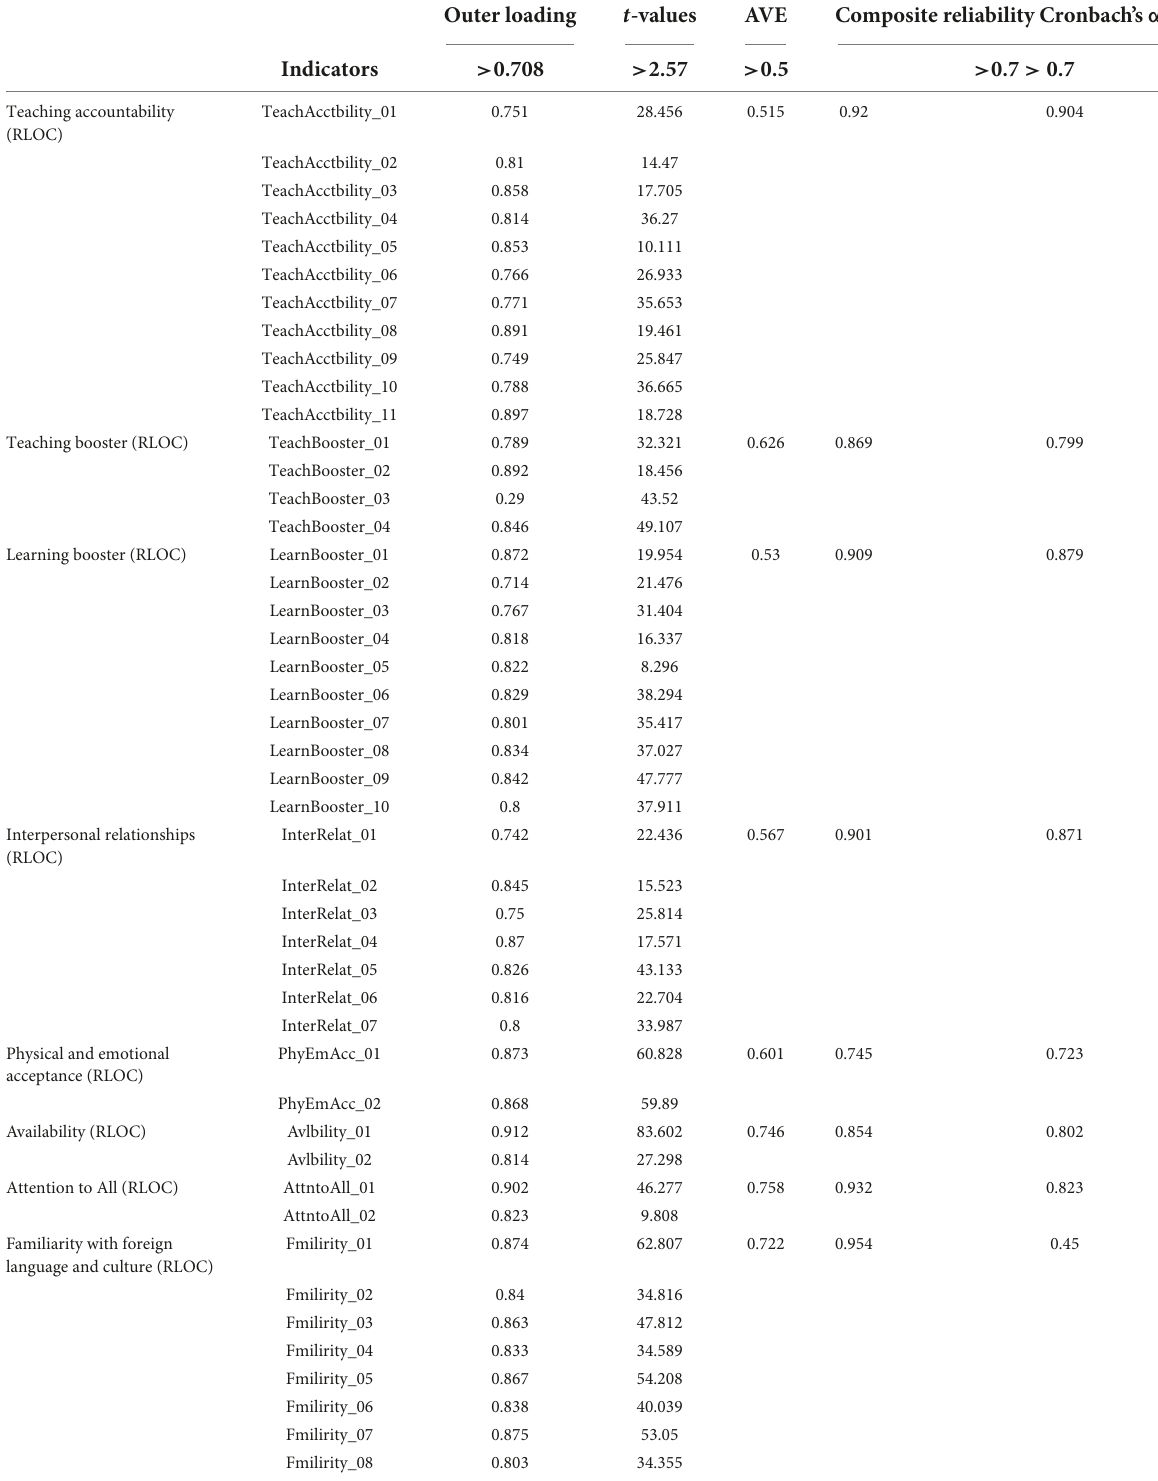
TABLE 3 Cronbach’s alpha, composite reliability, and convergent validity of teacher professional